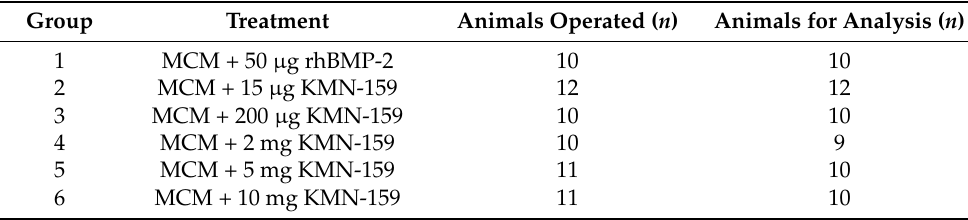
Table 1. Study overview including treatment groups, doses, and sample size ( n ). Group Treatment Animals Operated ( n ) Animals for Analysis ( n